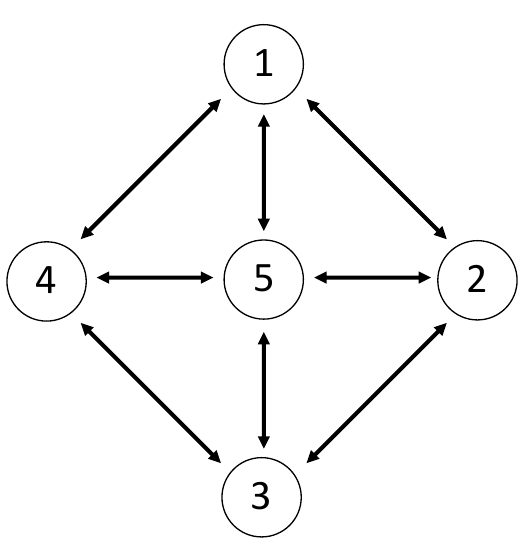
Figure 11. Interconnection graph of five satellites in a spaceborne telescope example. Interconnections between satellites are assumed to be